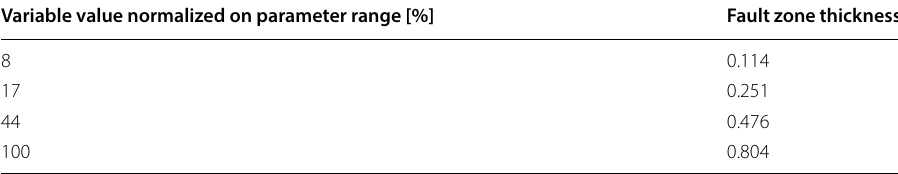
Table 4 Median values of SC x for the unevenly spaced fault zone thickness i ,min − x i , s , F j Variable value normalized on parameter range